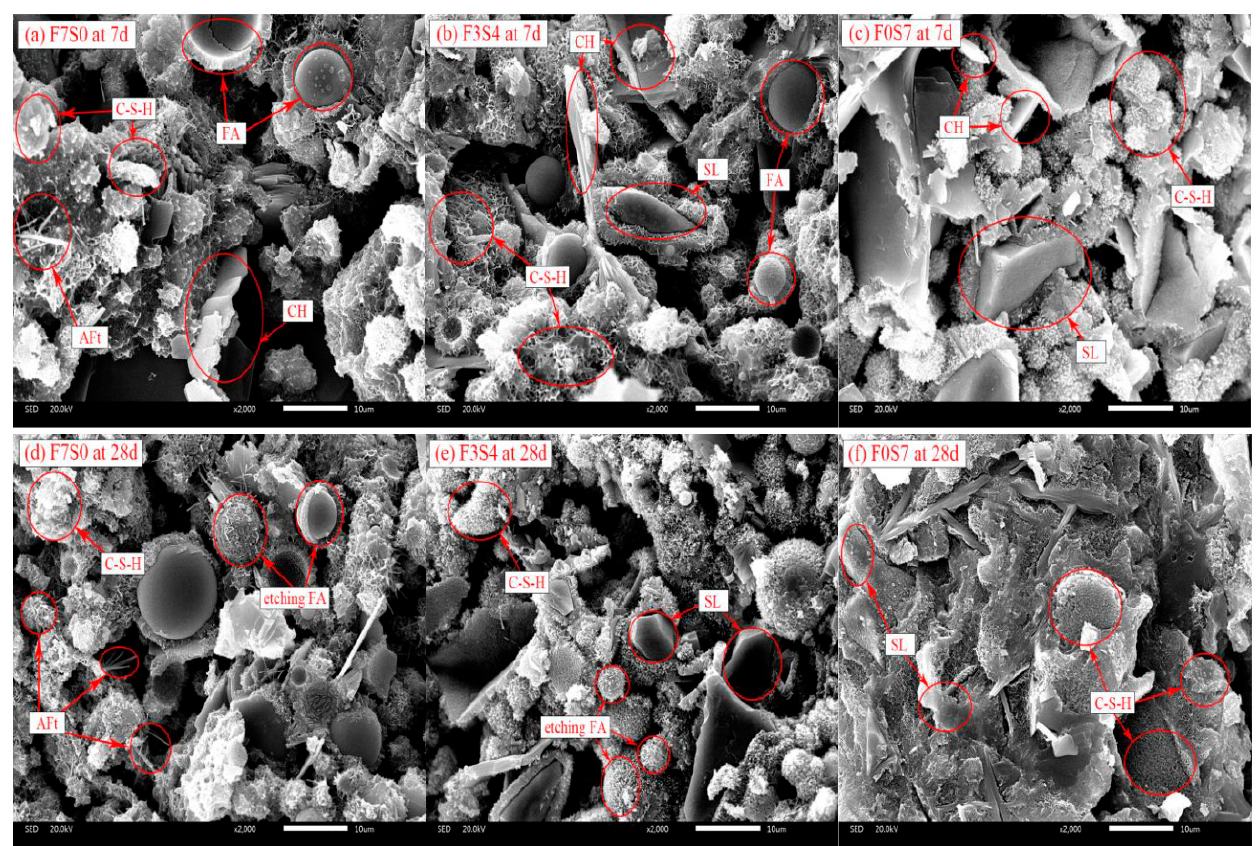
Figure 8. SEM images of the LCFLS at 2000× magnification. Table 6. Pore structure characterization of LCFLS.